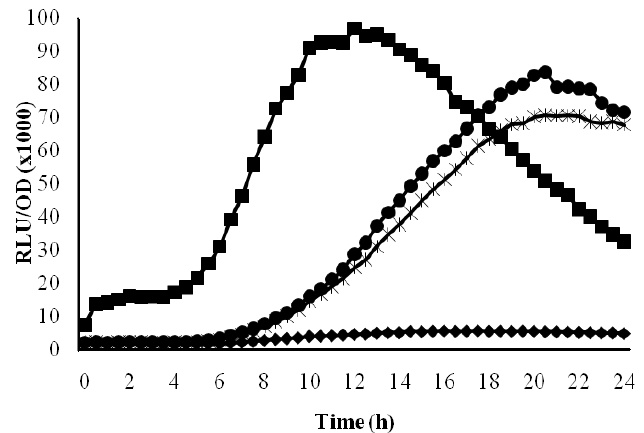
Figure 4. Measurement of bioluminescence. Bacterial bioluminescence and OD were measured throughout growth for 24 hours at 37 °C in the presence of synthetic C4-HSL (square) (positive control), ethyl acetate (diamond) (negative control), and AHL extracts from T2-1-1 ( K. pneumoniae ) (asterisk) and T2-1-2 ( K. pneumoniae ) (circle). E . coli [pSB401] served as the biosensor. Data represent means from three